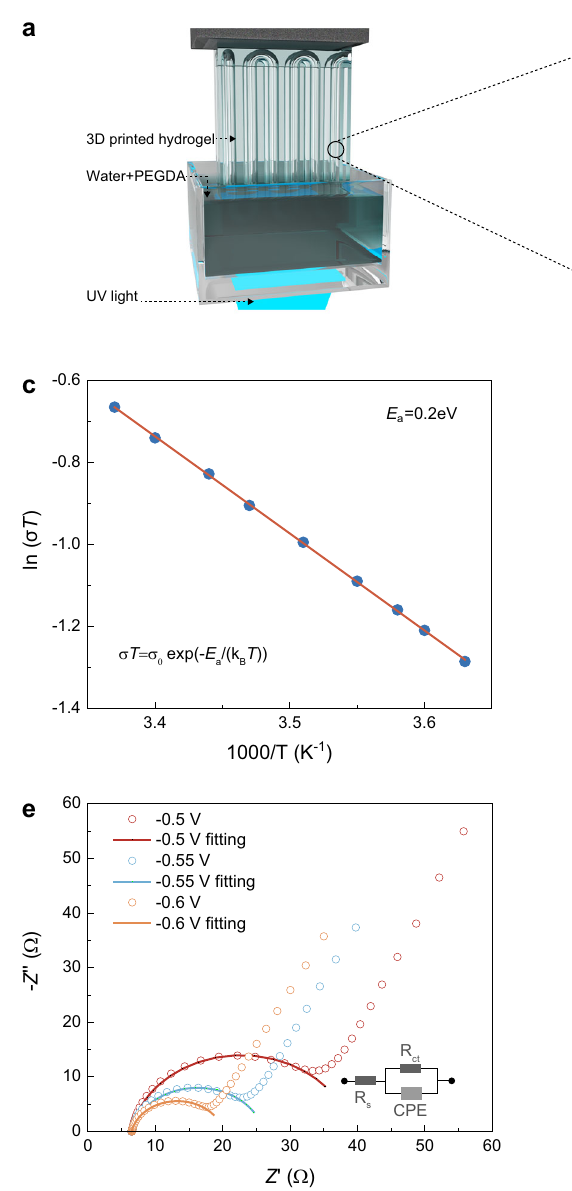
Fig. 2 | Electrochemical analysis for 3D printed hydrogel and VCr-PBA. a Schematic diagram of the 3D printed hydrogel for the magneto-ionic proton sensor. The UV light used has a wavelength of 385nm and the control of image projection was achieved through a dynamic micromirror device. b SEM image for the PEGDA scaffold in the 3D printed hydrogel. c The plot of ln( σ T) vs. 1000/T for VCr-PBA. σ T = σ 0 exp(- E a /( k B T )). σ refersto protonconductivity. E a is the activation energy. σ 0 representsthe pre-exponential factor, and k B represents the Boltzmann constant. d The speci fi c capacity-dependent potential during protonation and